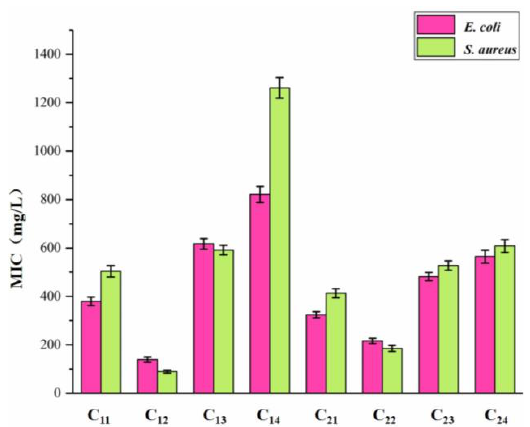
Figure 5. Inhibition zone diameter of DHP fractions on E. coli and S. aureus.